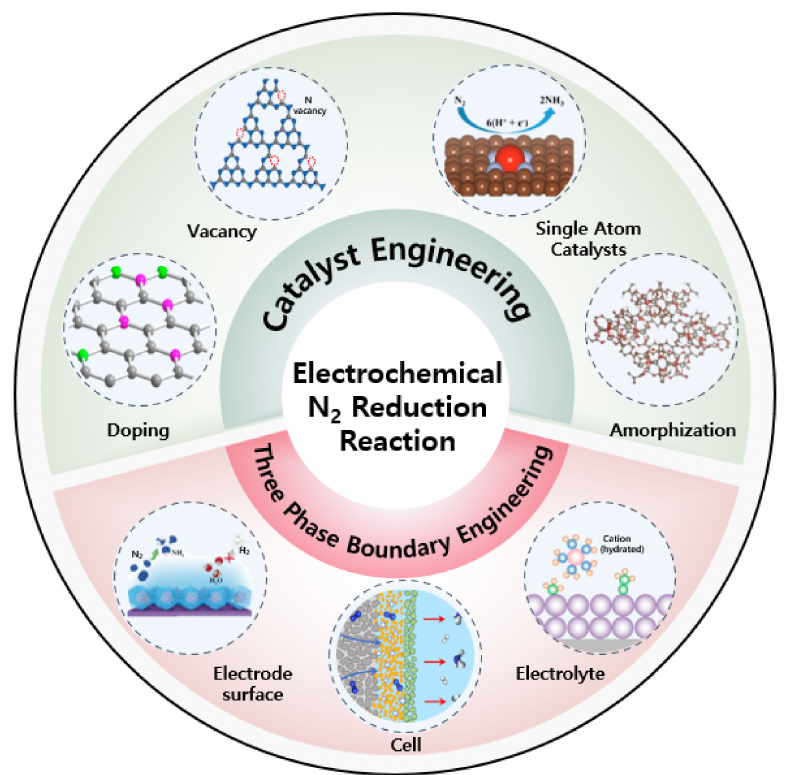
Scheme 1. Schematic diagram of electrochemical N 2 reduction reaction performance